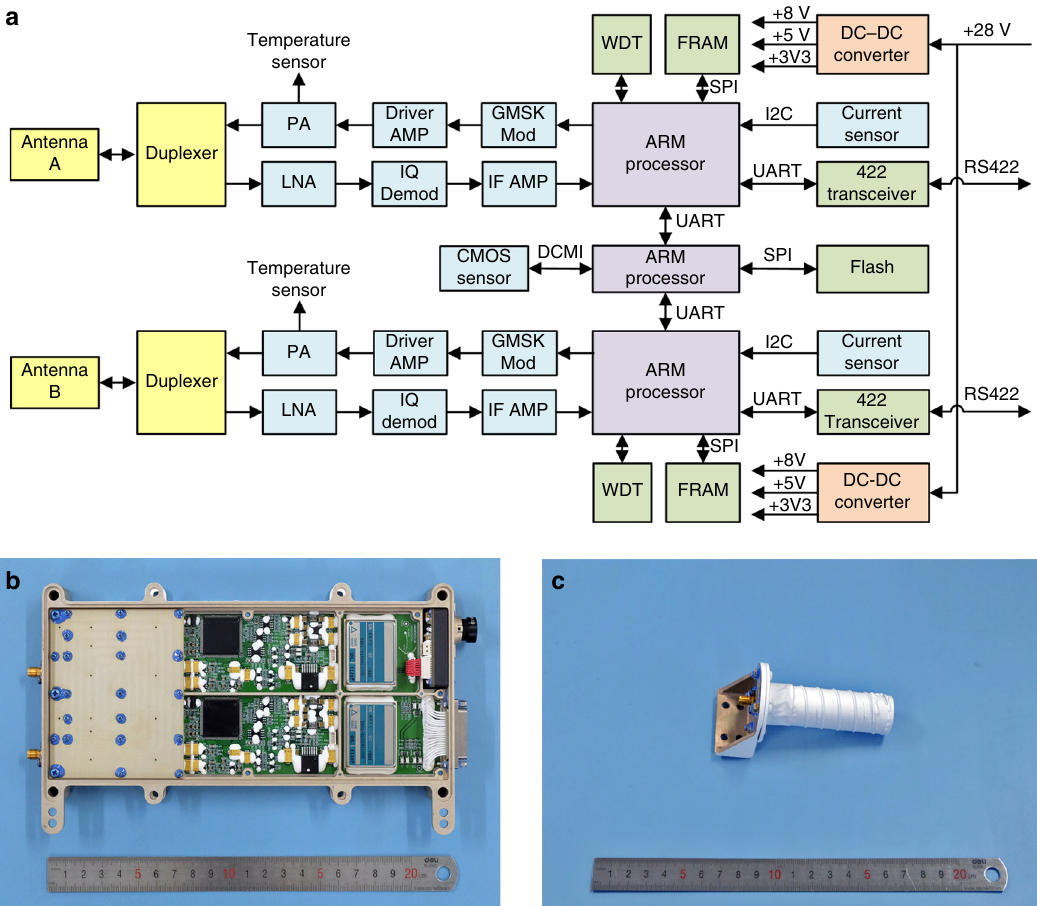
Fig. 2 Hardware of VHF/UHF radio. a Block diagram of VHF/UHF radio. b Flight hardware of the VHF/UHF transceivers and miniature CMOS camera. c Flight hardware of a VHF/UHF dual-band